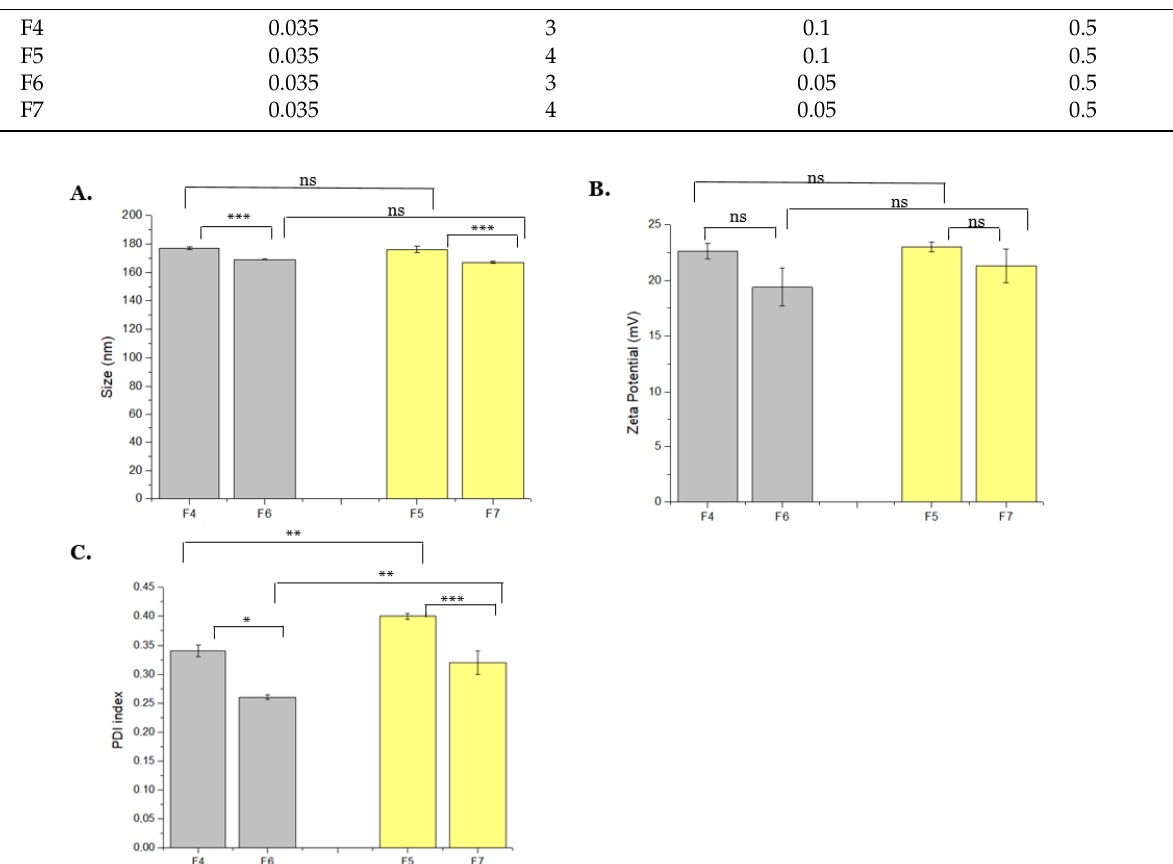
Figure 2. NPs ( A ) mean size (nm), ( B ) average zeta potential, ( C ) PDI, changing CS volumes and TPP concentrations (F4 to F7). The values were calculated with the data obtained from three independent measurements (mean ± S.D., n = 3) * p < 0.05; ** p < 0.01; *** p < 0.001; ns – not significant. Gray – CS volume of 3 mL, Yellow – CS volume of 4 mL.